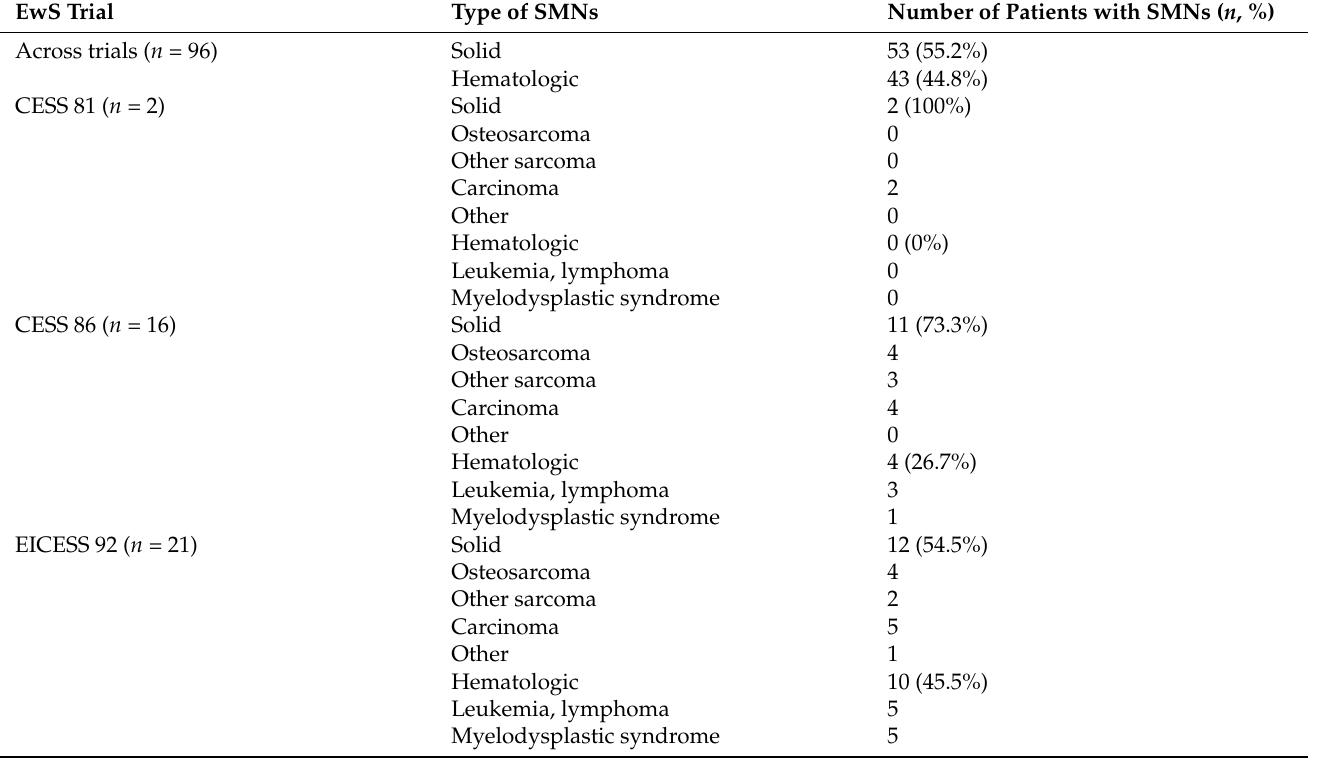
Table 3. Types of secondary malignant neoplasms (SMNs) of 96 primary Ewing sarcoma